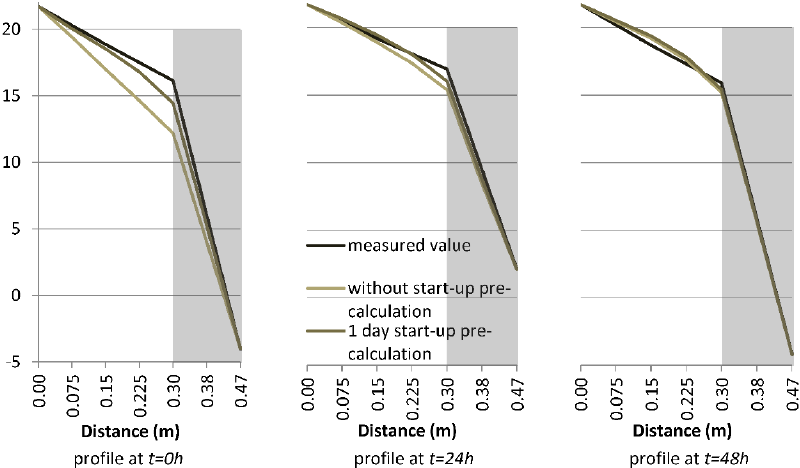
Figure 17. Temperature profile across the outdoor test cell wall S1 at t = 0 h, t = 24 h and t = 48—with and without pre-calculation considerations.